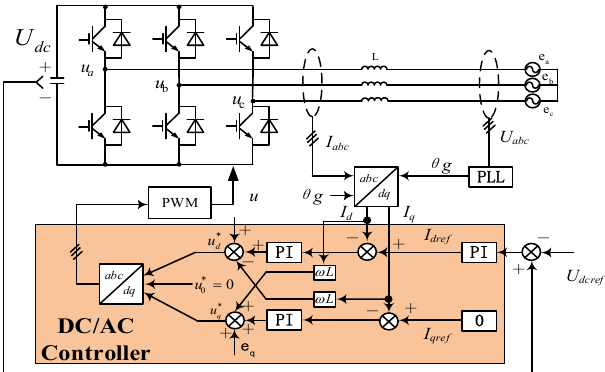
Figure 8. Control strategy of DC/AC inverter.